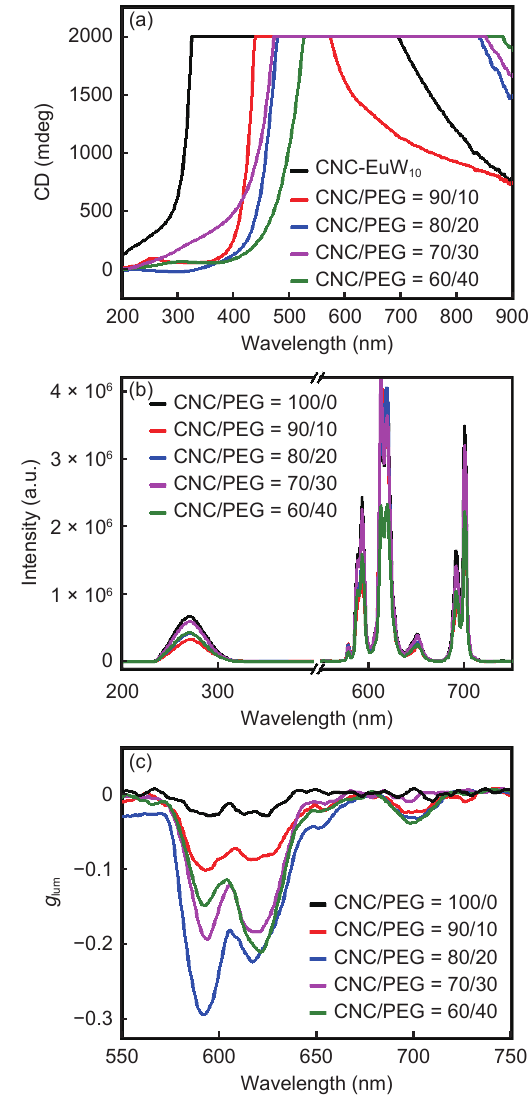
Figure 4 (a) CD spectra, (b) fluorescence spectra (excitation wavelength = 270 nm) and (c) CPL spectra of CNC/PEG/EuW 10 composite films with different CNC/PEG mass ratios when RH =